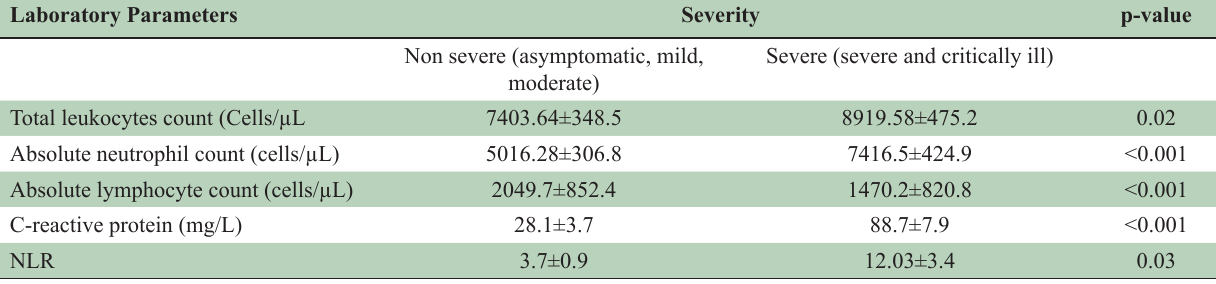
Table-II: Laboratory parameters of COVID-19 patients.